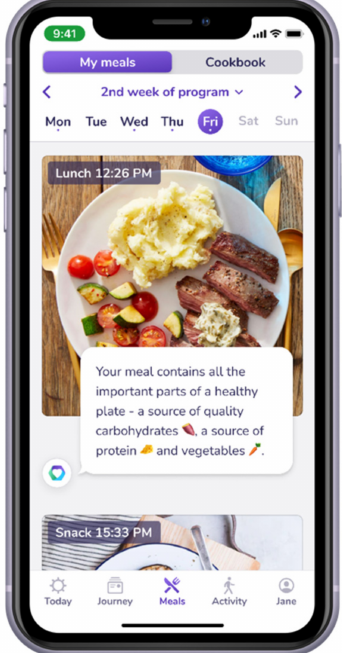
Figure A1. In-app meal logging function with automatic